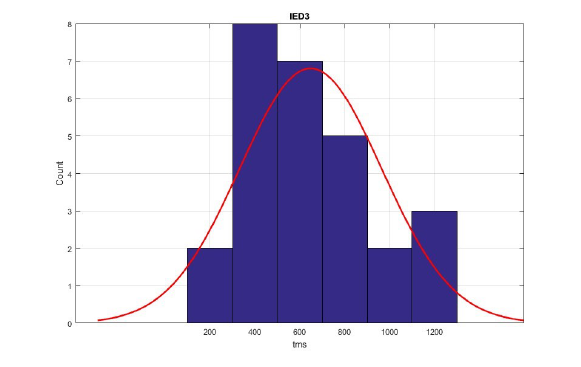
Figure 8: Histogram for the DPST.ECPConn based IED1-IED3 round trip time